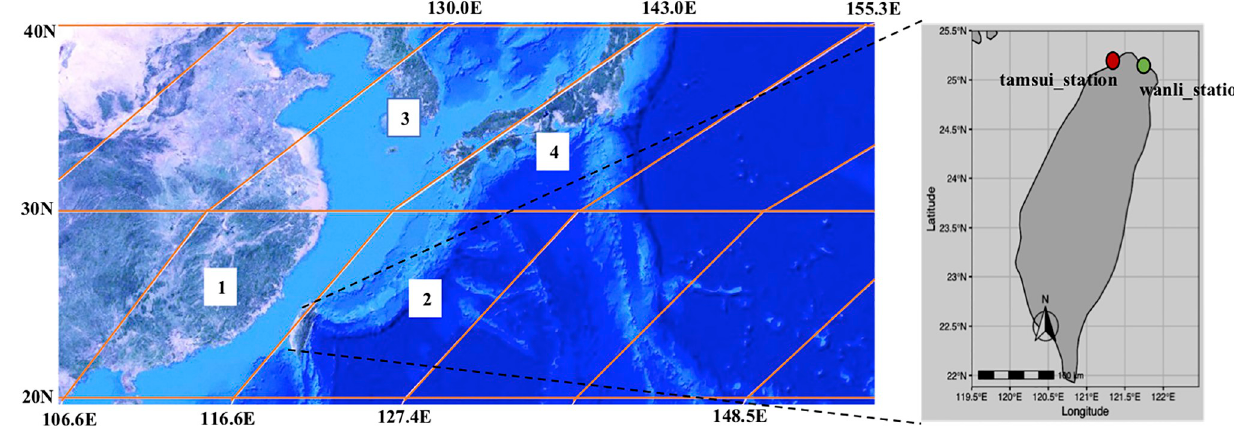
Fig 1. Study area. Left side: Four tiles (adapted from NASA) label 1( h 28 v 06),2( h 29 v 06), 3( h 28 v 05), 4( h 29 v 05)with Taiwan in the middle between tiles 1 and 2. Right side: The map of Taiwan after zooming with two stations Wanli (red circle) and Tamsui (green circle).